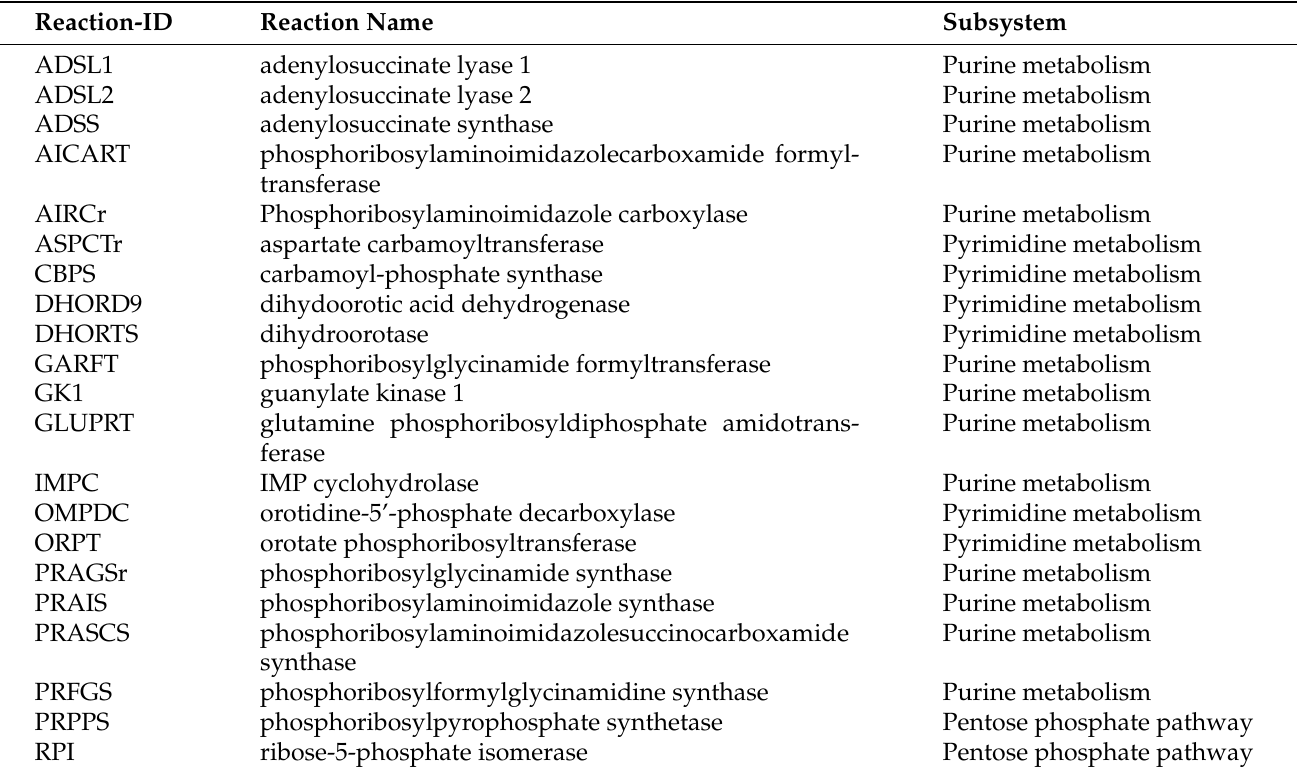
Table A1. Reactions from the host-derived enforcement experiments. The reaction identifiers listed in Figure 2 are BiGG identifiers [28]. In this table, the BiGG reaction identifiers are given, together with the reaction name and the subsystem, they occur